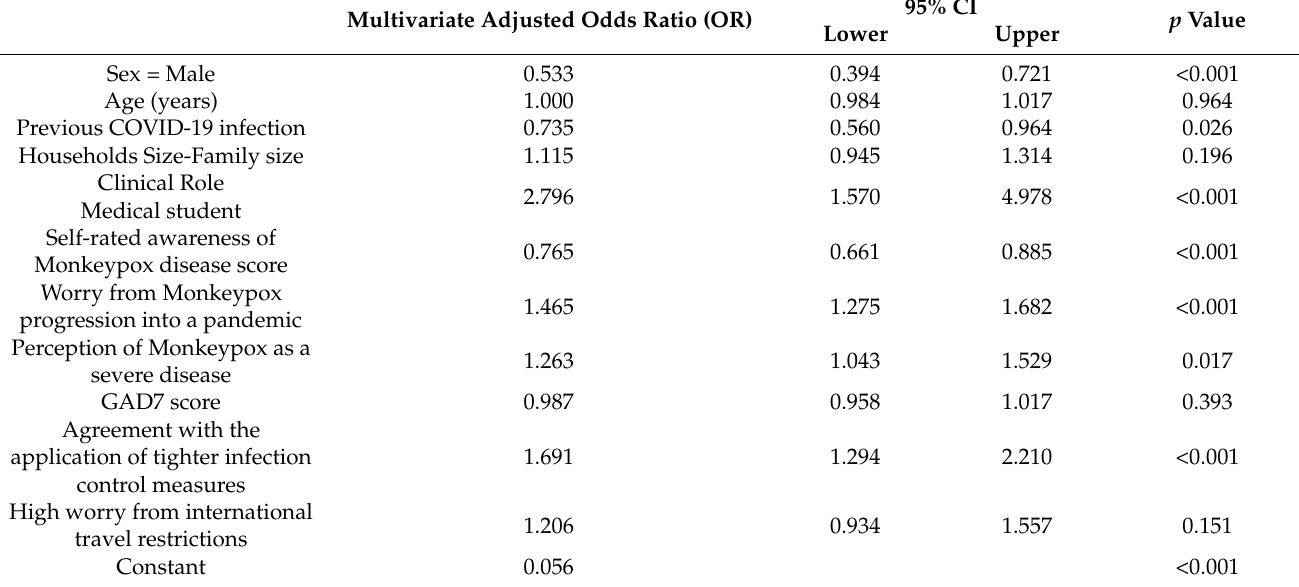
Table 4. Multivariate binary logistic regression analysis of the HCW’s odds of high worry from Monkeypox compared to COVID-19.